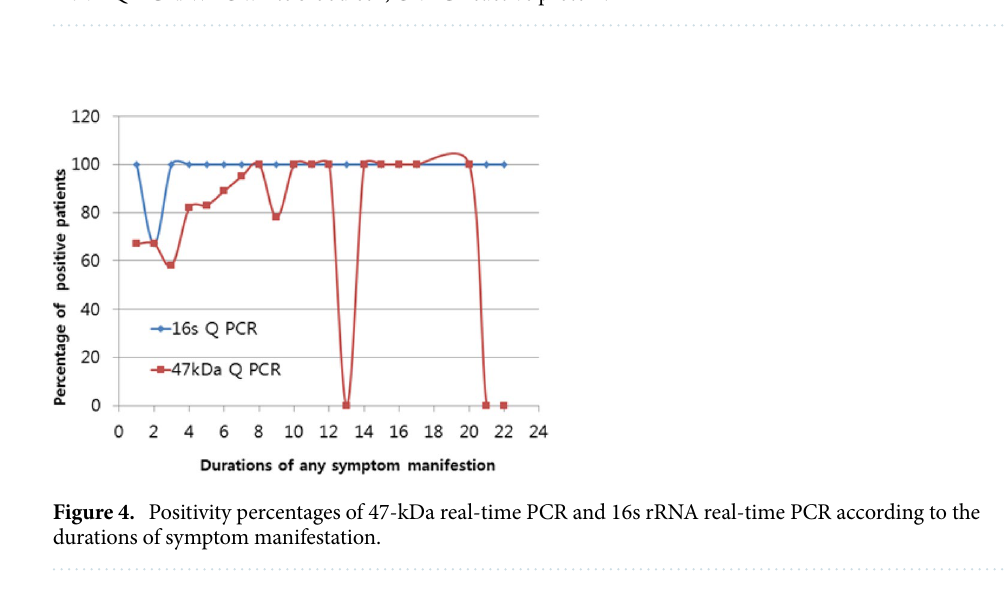
Table 4. Correlation between laboratory findings and copy number determined using 47-kDa Q-PCR and 16S rRNA Q-PCR. WBC white blood cell, CRP C-reactive protein.